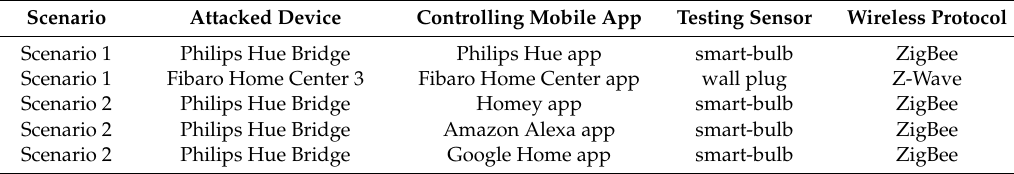
Table 1. A brief overview of the cases used during the experimental